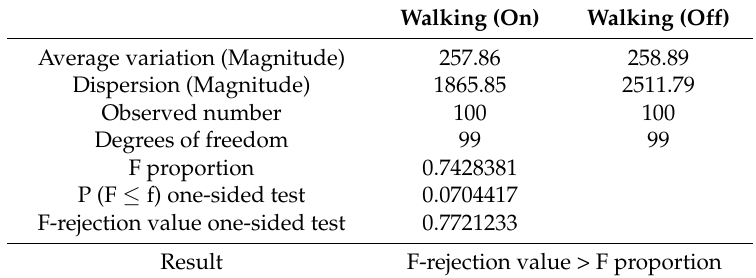
Table 3. F-test results for SVM during walking according to whether or not the chinstrap on the safety helmet was